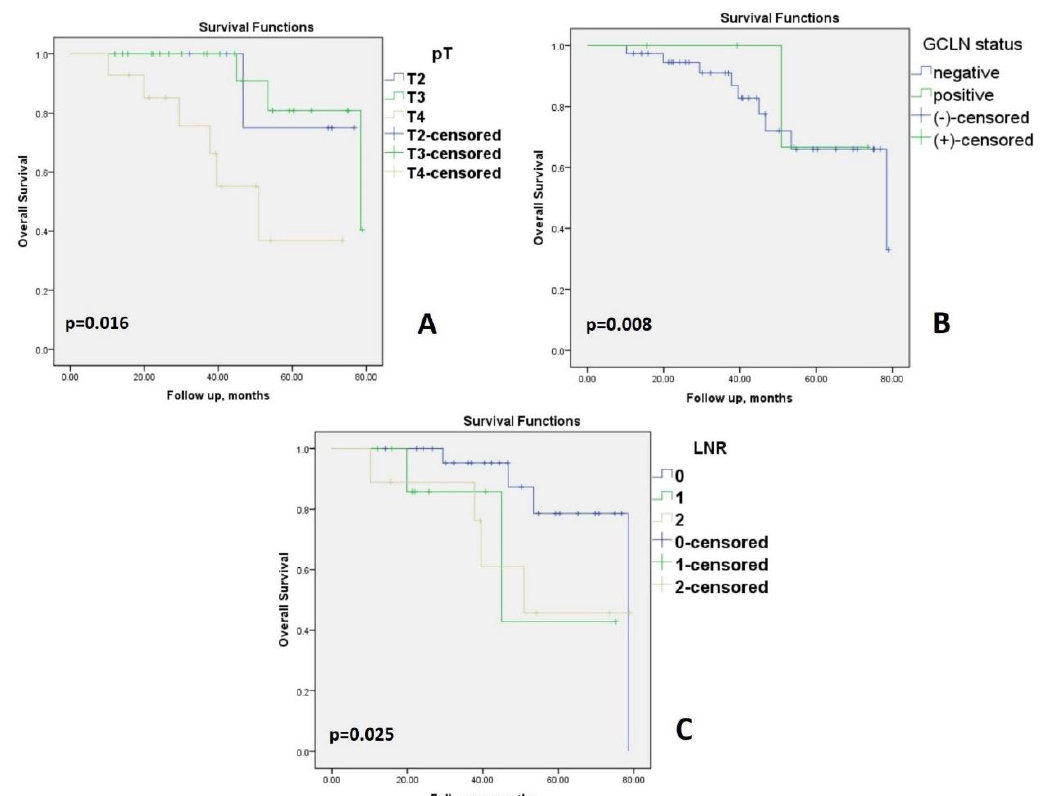
Figure 4. Kaplan – Meier overall survival analysis in patients with proximal transverse colon cancer. ( A ) Overall survival curves by stage pT2/3/4 (pathological tumor). ( B ) Kaplan – Meier survival curve by GCLN status. ( C ) Survival curves in different lymph node ratio groups; LNR = lymph node ratio: 0 = LNR < 0.05; 1 = LNR ranges from 0.05 to 0.20; 2 = LNR > 0.20.